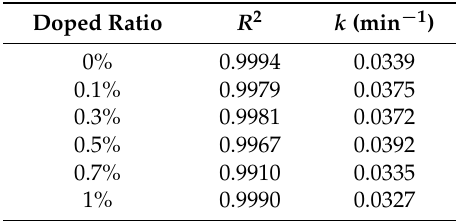
Table 1. Parameters of the first-order reaction